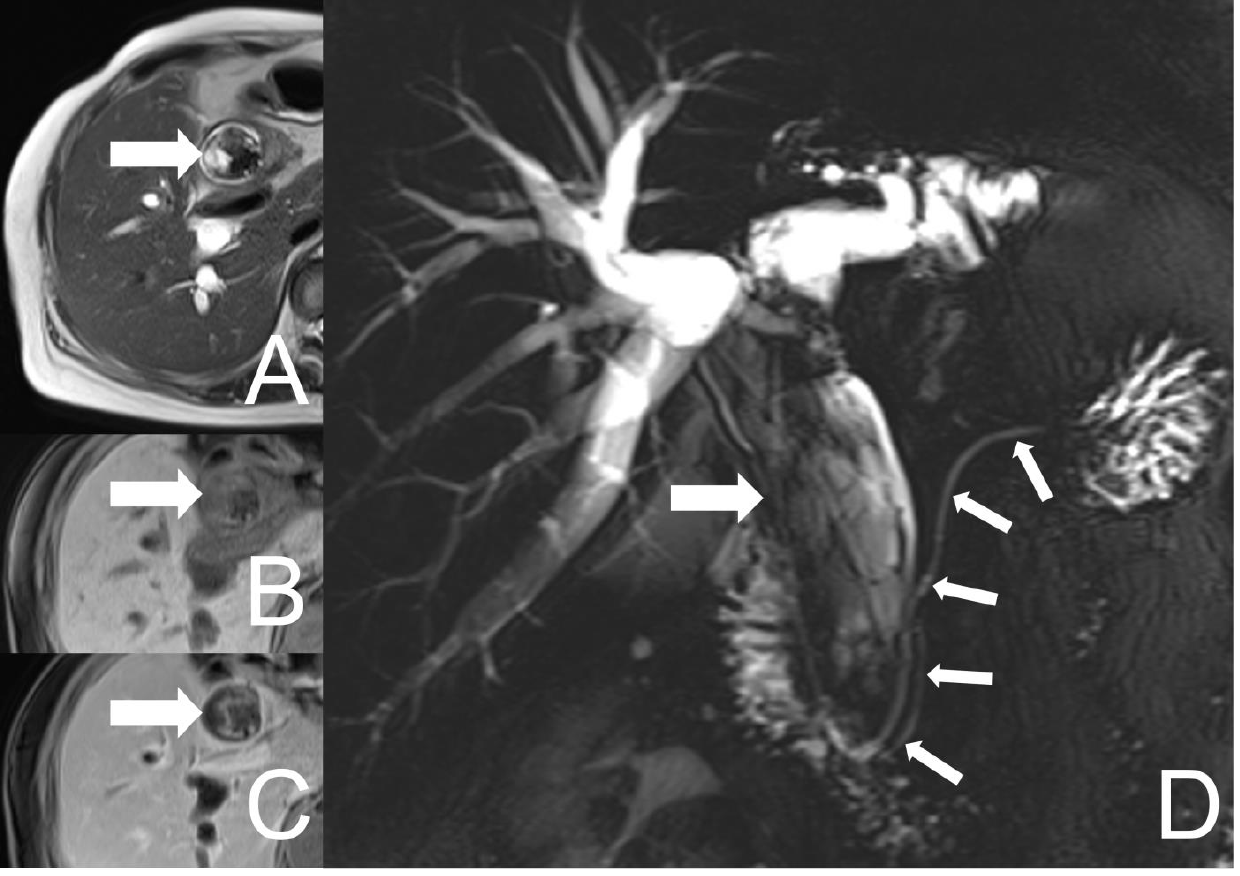
Figure 3. UCOGC of CHD and CBD in a 66-year-old female, 10 months after the initial presentation. The tumor (thick arrow) shows an increase in size with more conspicuous cystic parts on the axial T2-weighted image ( A ), and more conspicuous heterogeneous signal intensities and enhancement on the axial pre- and post-contrast T1-weighted fat-saturated images ( B , C ). The hypointensities of the lesion on both T1- and T2-weighted images could be suggestive of hemosiderin deposition. The MRCP ( D ) reveals the tumor occupying the whole CHD and CBD, with the dilatation of the biliary tract. Neither tumor involvement nor dilatation of the pancreatic duct were found (thin arrows).